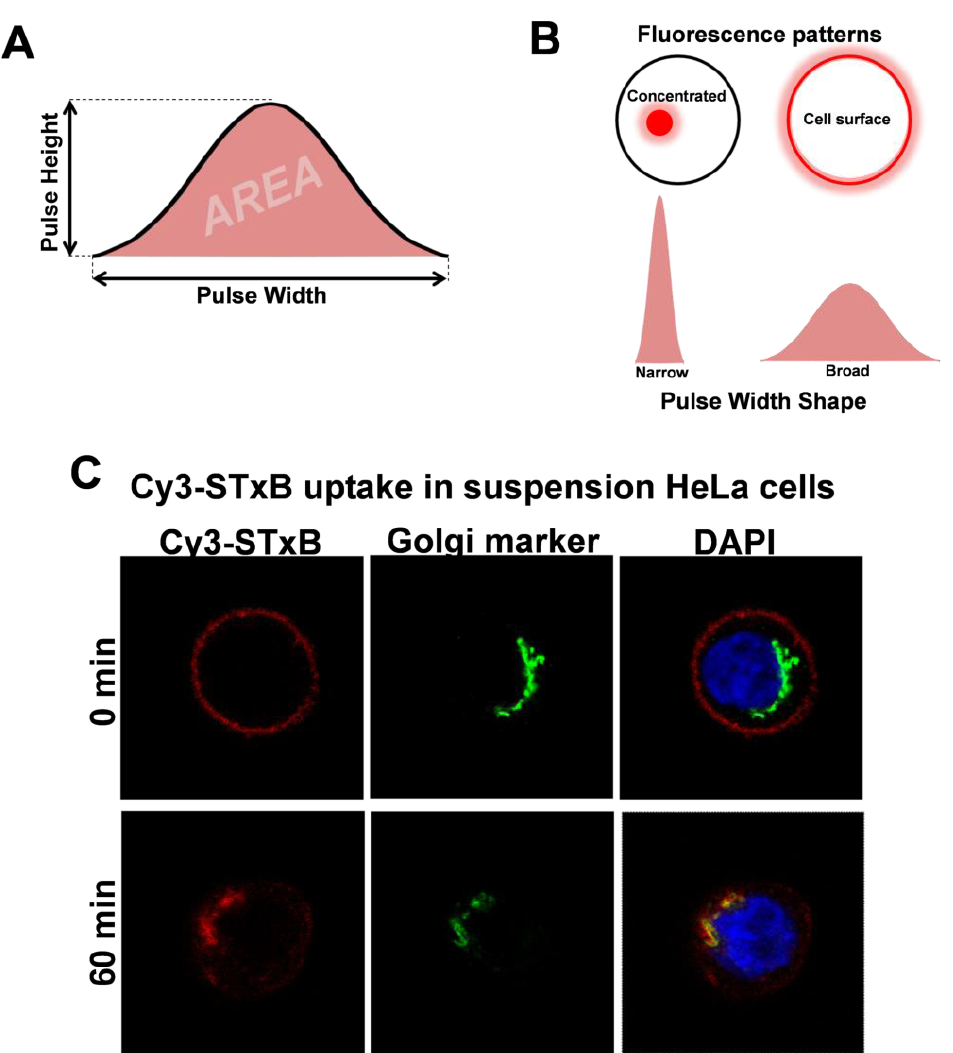
Figure 2. Flow cytometry pulse width can be used for quantitation of cargo localization . (A) The fluorescence signal of a fluorescent particle as it moves through the detector of a flow cytometer. The maximum height of the signal is the pulse height, and the pulse width is a measure of the return of the signal to a basal level. The total area under the curve is the pulse area. (B) The different pulse width shapes resulting from either a concentrated small area of intracellular fluorescence or cell surface fluorescence. (C) A Cy3-STxB internalization assay was carried out in HeLa cells in suspension. Briefly, a single cell suspension of HeLa cells was incubated with Cy3-STxB on ice and either fixed with 4% paraformaldehyde/PBS immediately (0 min) or allowed to internalize at 37 °C for 60 min, Cl/PBS, permeabilized prior to fixation (60 min). Cells were quenched with 50 mM NH 4 with 0.1% Triton X-100/PBS and blocked with 5% FCS/PBS, followed by staining with mouse anti-GM130 (green) and DAPI (blue). A coverslip was applied onto a drop of the cell suspension on a glass slide and sealed with varnish for imaging on a Leica SP2 confocal microscope. (D) The pulse width histograms from flow cytometry analysis of 10,000 HeLa cells from each time-point of the Cy3-STxB internalization assay. At 0 min, the pulse width distribution is broad (pink), but this distribution becomes narrower and shifts to the left after 60 min of internalization at 37 °C